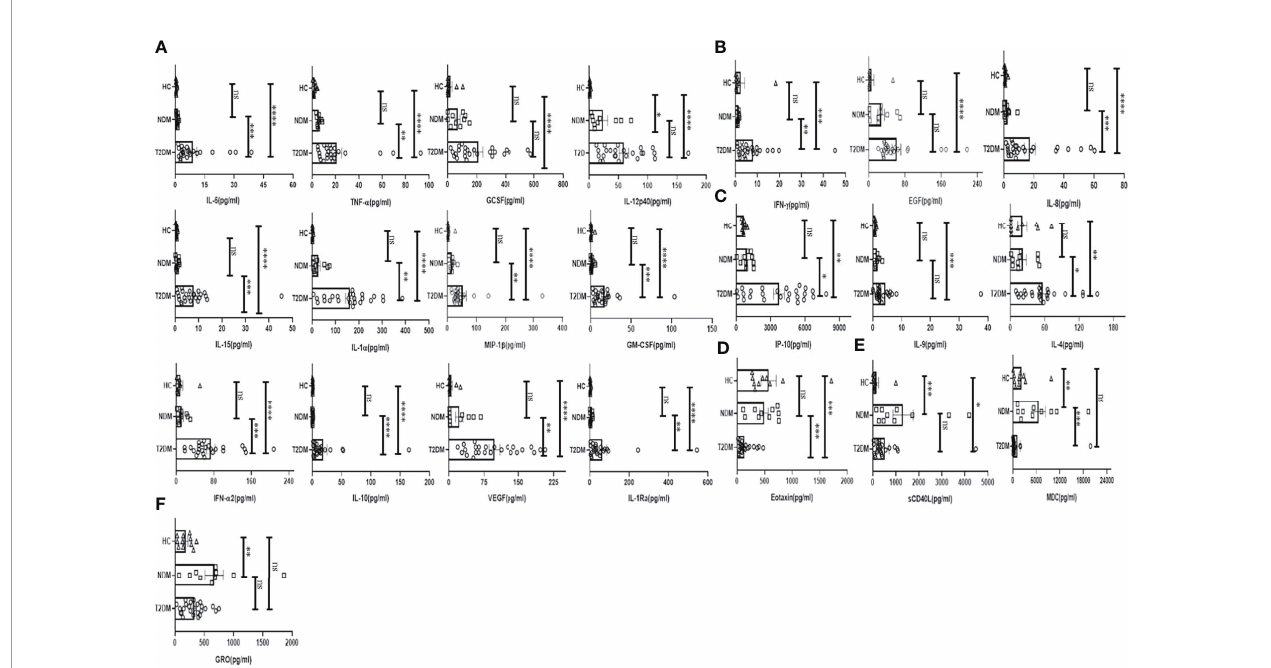
FIGURE 2 | Analysis of the cytokines and chemokines in T2DM, NDM patients infected with SARS-CoV2. The bar diagrams represent cytokines and chemokines which were evaluated from COVID -19 positive plasma samples of T2DM (n = 25), NDM (n = 10), and Covid-19 negative and non-diabetic healthy controls (n = 10). (A) IL-6. TNF- a , GCSF, IL-12p40, IL-15, IL-1 a , MIP-1 b , GMCSF, IFN- a 2, IL-10, VEGF, and IL-R a were highly elevated in T2DM patients when compared with healthy controls and NDM patients. (B) IFN- g , EGF, and IL-8 were moderately elevated in T2DM patients when compared to healthy controls and NDM. (C) IP-10, IL-9, and IL-4 were slightly elevated in T2DM patients when compared to healthy controls and NDM. (D) Eotaxin was moderately elevated in healthy controls and NDM when compared to T2DM patients. (E) sCD40L was elevated in both NDM and T2DM when compared to healthy controls, MDC was elevated in NDM patients when compared to T2DM patients. (F) GRO was elevated in NDM patients when compared to healthy controls. The Kruskal Wallis Test (non-parametric) with post- hoc Dunn ’ s multiple comparison test was performed. p < 0.05 was considered statistically signi fi cant (*), p < 0.01 was considered to be very signi fi cant (**), P < 0.001 was considered to be highly signi fi cant (***), P < 0.0001 was considered to be extremely signi fi cant (****), ns, not signi fi cant. All error bars were